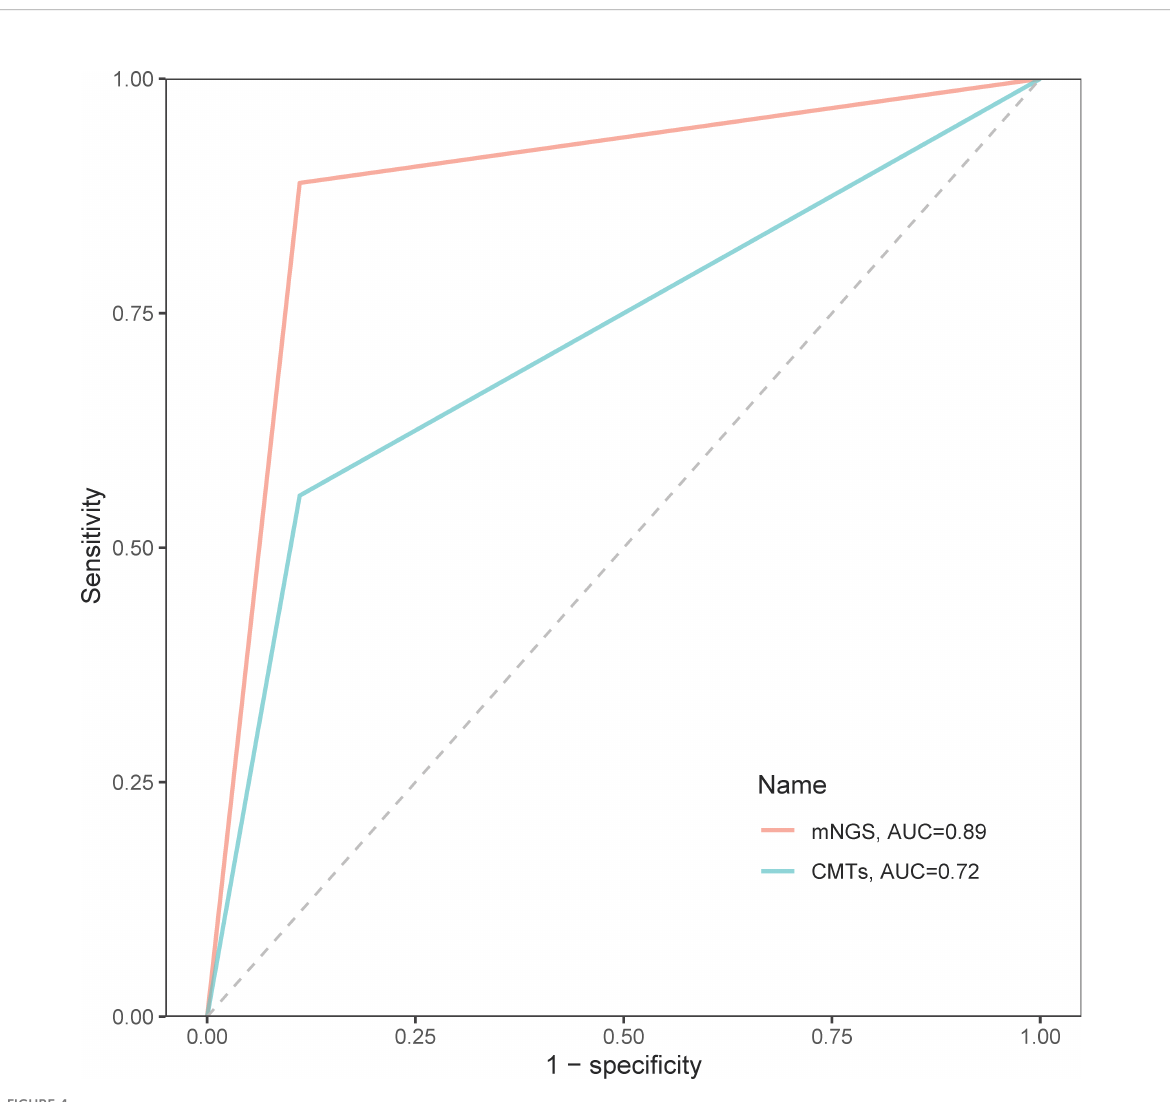
FIGURE 4 The receiver operator characteristic curves of mNGS and CMTs in the diagnosis of spinal infection.